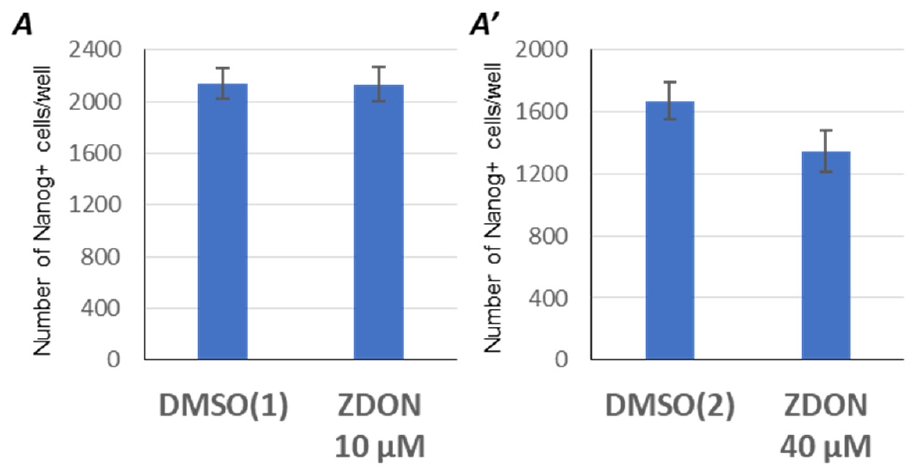
Figure 3. Serotonylation is not involved in the reprogramming to pluripotency. Inhibiting serotony- lation with 10 µ M ( A ) or 40 µ M ZDON ( A’ ) does not enhance the reprogramming efficiency of wild-type MEFs, as compared to cells treated with corresponding concentrations of vehicle, desig- nated as DMSO (1) and (2). Y -axes represent counts of the Nanog-positive iPSC clones ± SD; n = 3 (technical replicates); p < 0.005.